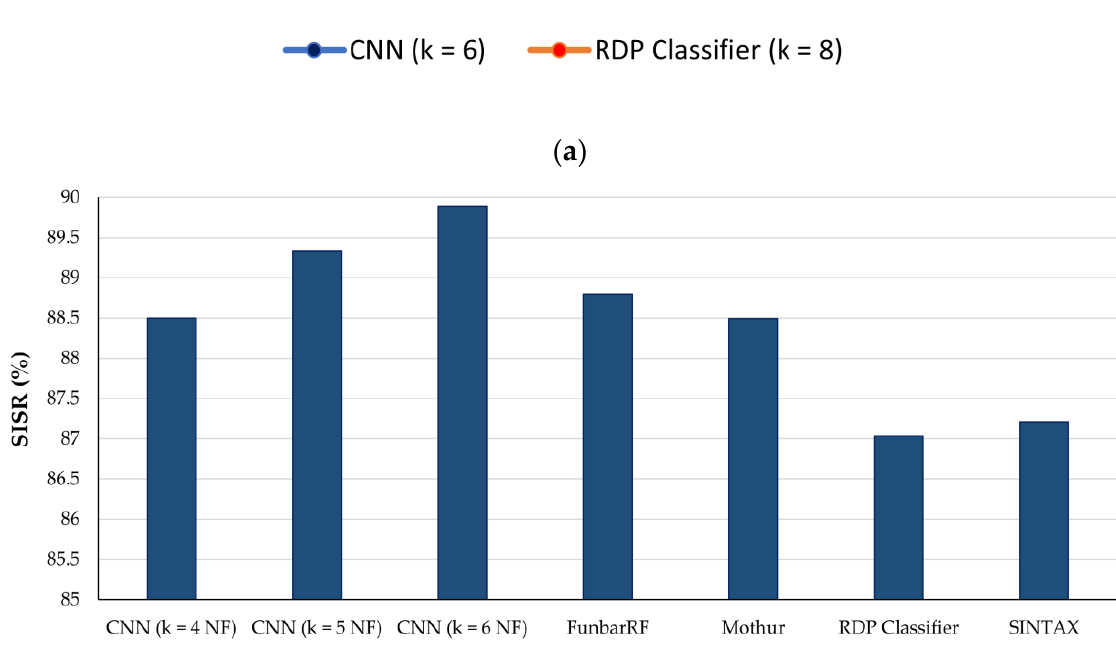
Figure 8. ( a ) Comparison between CNN and RDP Classifier based on average accuracy (%) at various taxonomic levels, ( b ) Comparison between CNN and existing software in terms of SISR (%) scores for funbarRF dataset [50].